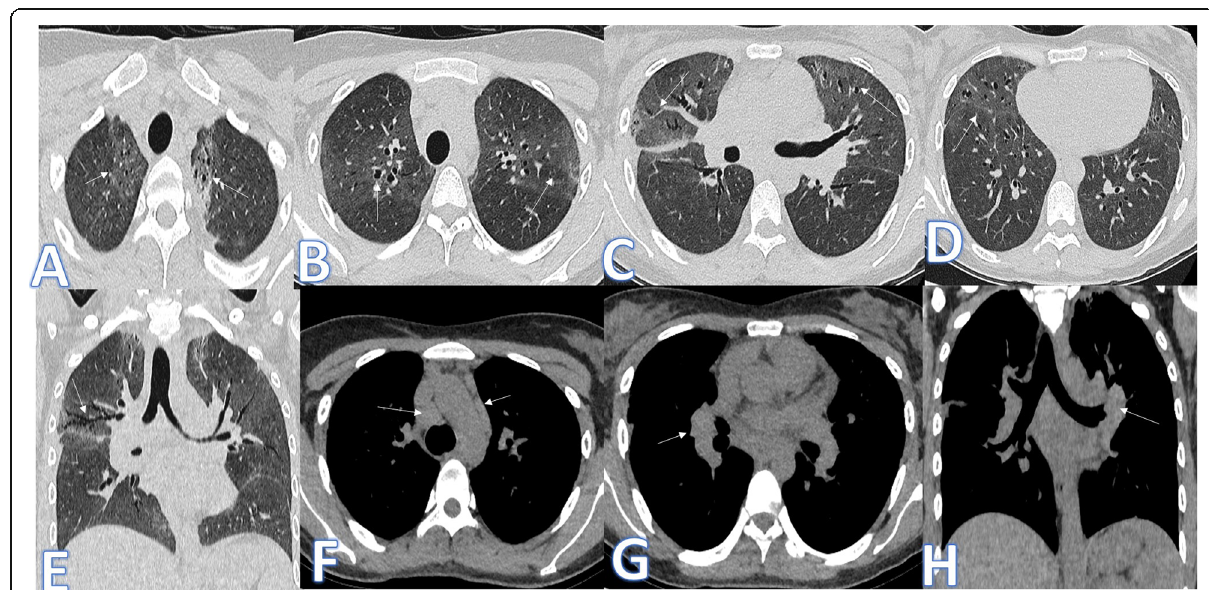
Fig. 12 A 30-year-old female patient known of sarcoid disease presented with cough; there was bilateral patchy ground glass appearance with mild bronchiectatic changes (arrows) and fibrotic changes of the upper lobe predilection. Multiple enlarged prevascular, pre/paratracheal, and hilar LNS was seen in mediastinal window (arrows in f – h )